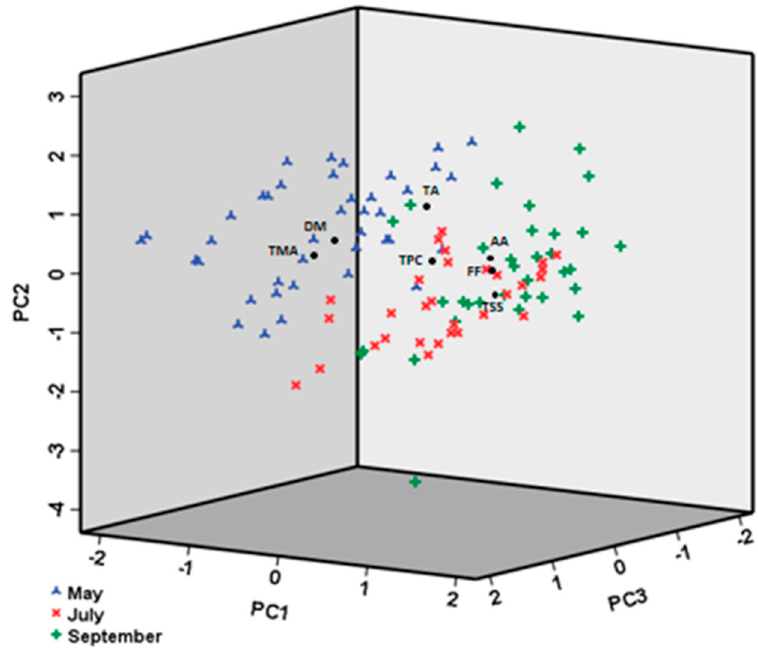
Figure 6. Score plot from the principal component analysis per harvest time (May, July, and September). TA = total acidity; TSS = total soluble solid content; DM = dry matter; FF = flesh firmness; TPC = total phenols content; AA = antioxidant activity; TMA = total anthocyanin content.